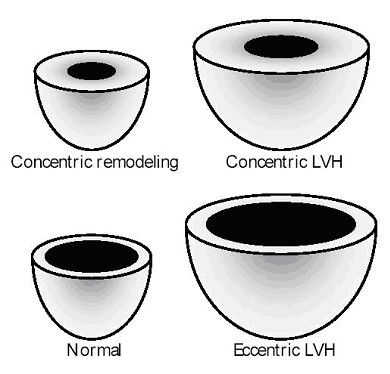
Geometric Patterns.